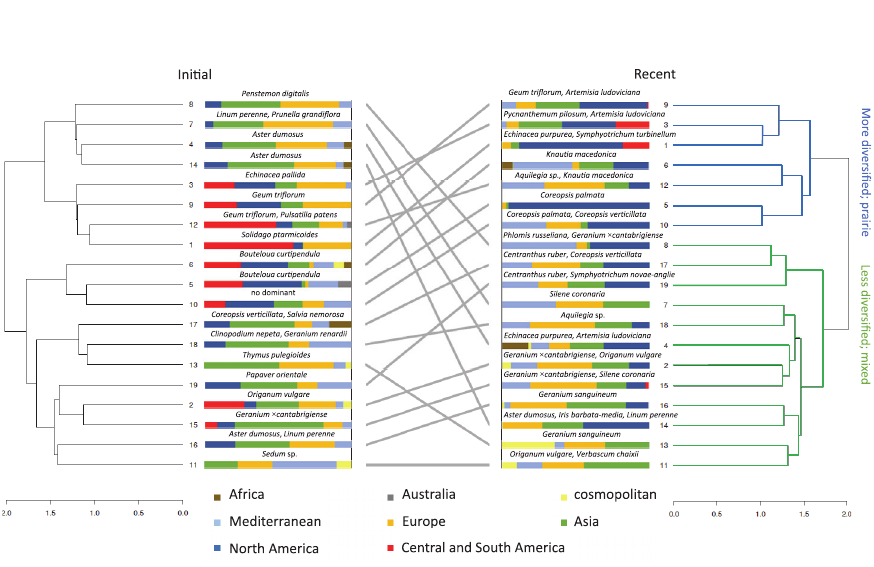
Figure 3. Cluster tree diagrams comparing initial and recent assemblages based on the average abun- dance. The cluster analysis distinguished two main clusters in the recent time assemblages. The bars repre- sent the percentage contribution of taxa for a given origin. Only taxa that are highly abundant in the FB are shown by names. As the dominant taxa change over time, they are shown for both initial and recent